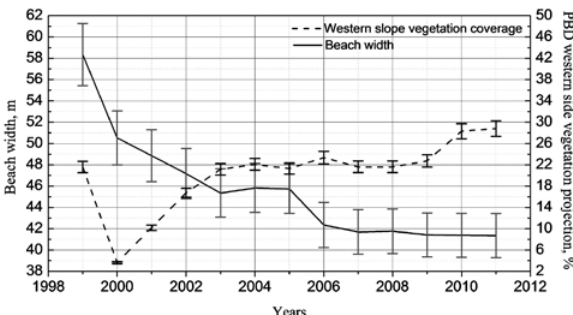
Fig. 9. Changes of beach width and the PBD western side vegetation coverage